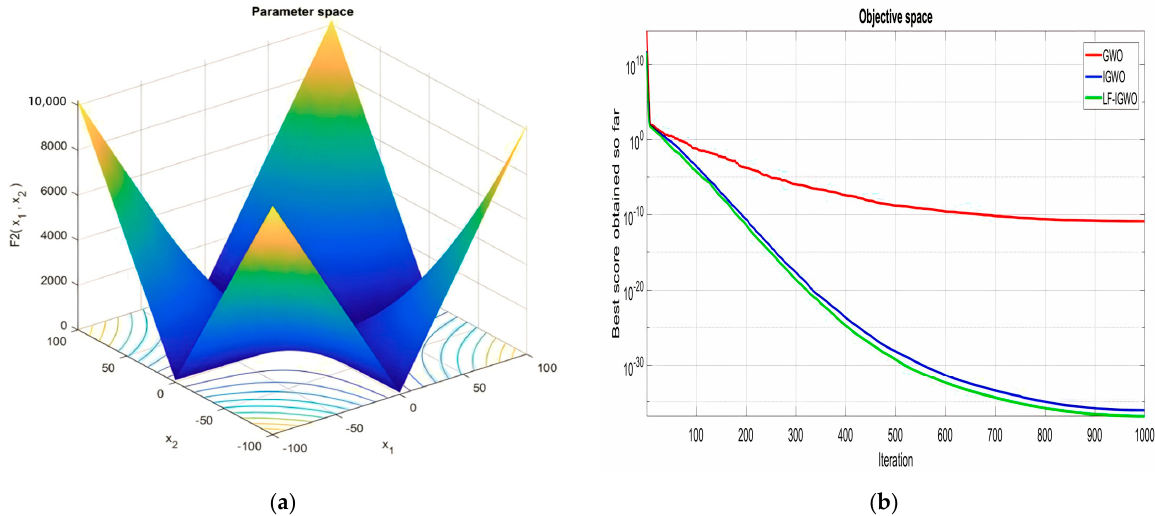
Figure 4. ( a ) Search space for unimodel function F02 ( b ) Comparison of convergence curve for F02.